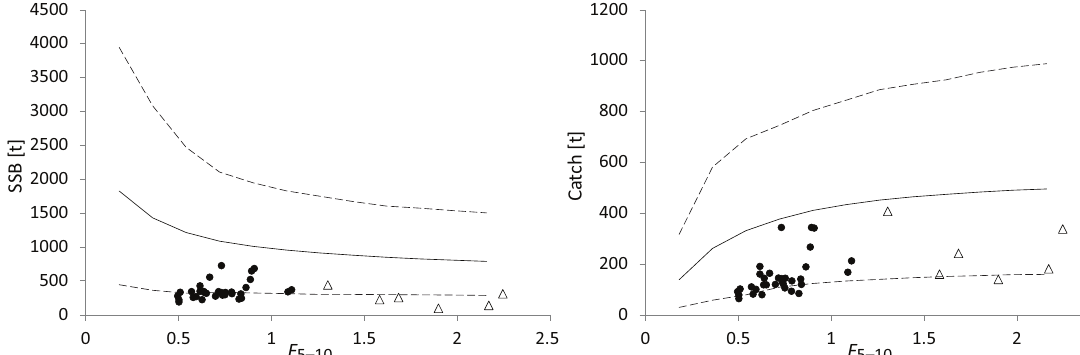
Fig. 5. Selected population characteristics of the Pärnu Bay pikepearch ( Sander lucioperca ): Spawning stock biomass (left) and catch (right) in equilibrium with different levels of fishing mortality at “future” climate conditions; Lines show average simulated SSB and catch (continuous), with 5% and 95% percentiles (dashed); Markers denote observed SSB and catches (Eero 2004) with no (circles) and significant (triangles) catch of immature fish; F 5–10